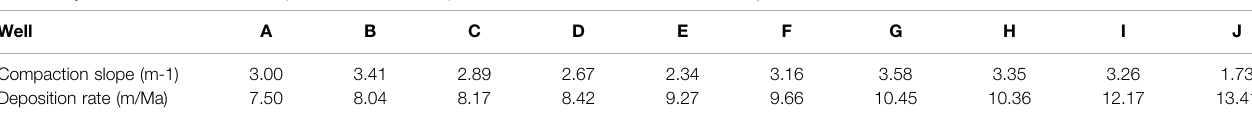
TABLE 1 | Sedimentation rate and slope in the normal compaction section of some wells in the study area.